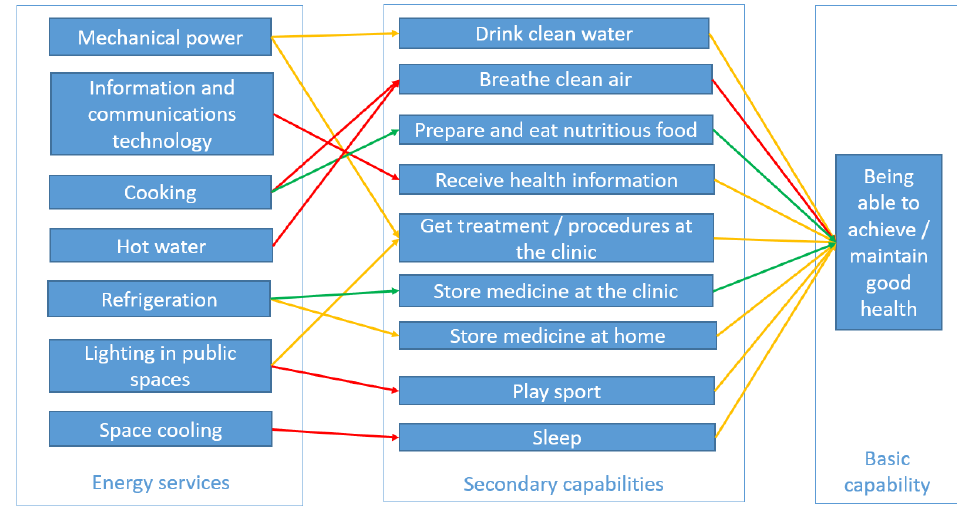
Figure 2. Connections between energy services, secondary capabilities and the ability to maintain good health.